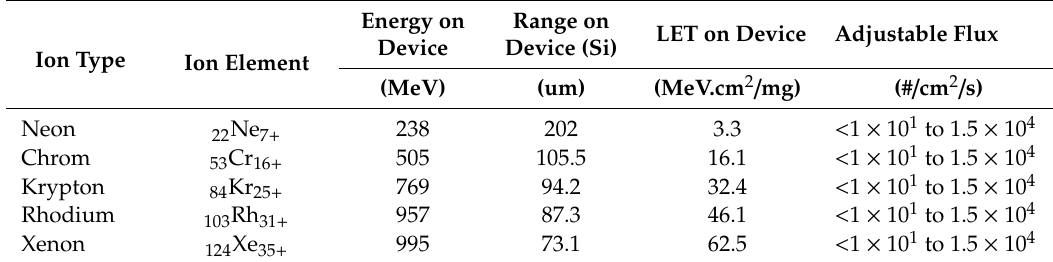
Table 2. Ion, linear energy transfer (LET), range and flux based on the Catholic University of Louvain (UCL) heavy ion facility (HIF)